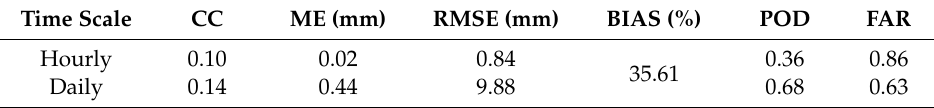
Table 3. Evaluation indices of IMERG-E at basin scale for the entire period (2011–2018). Time Scale CC ME (mm) RMSE (mm) BIAS (%) Hourly 0.10